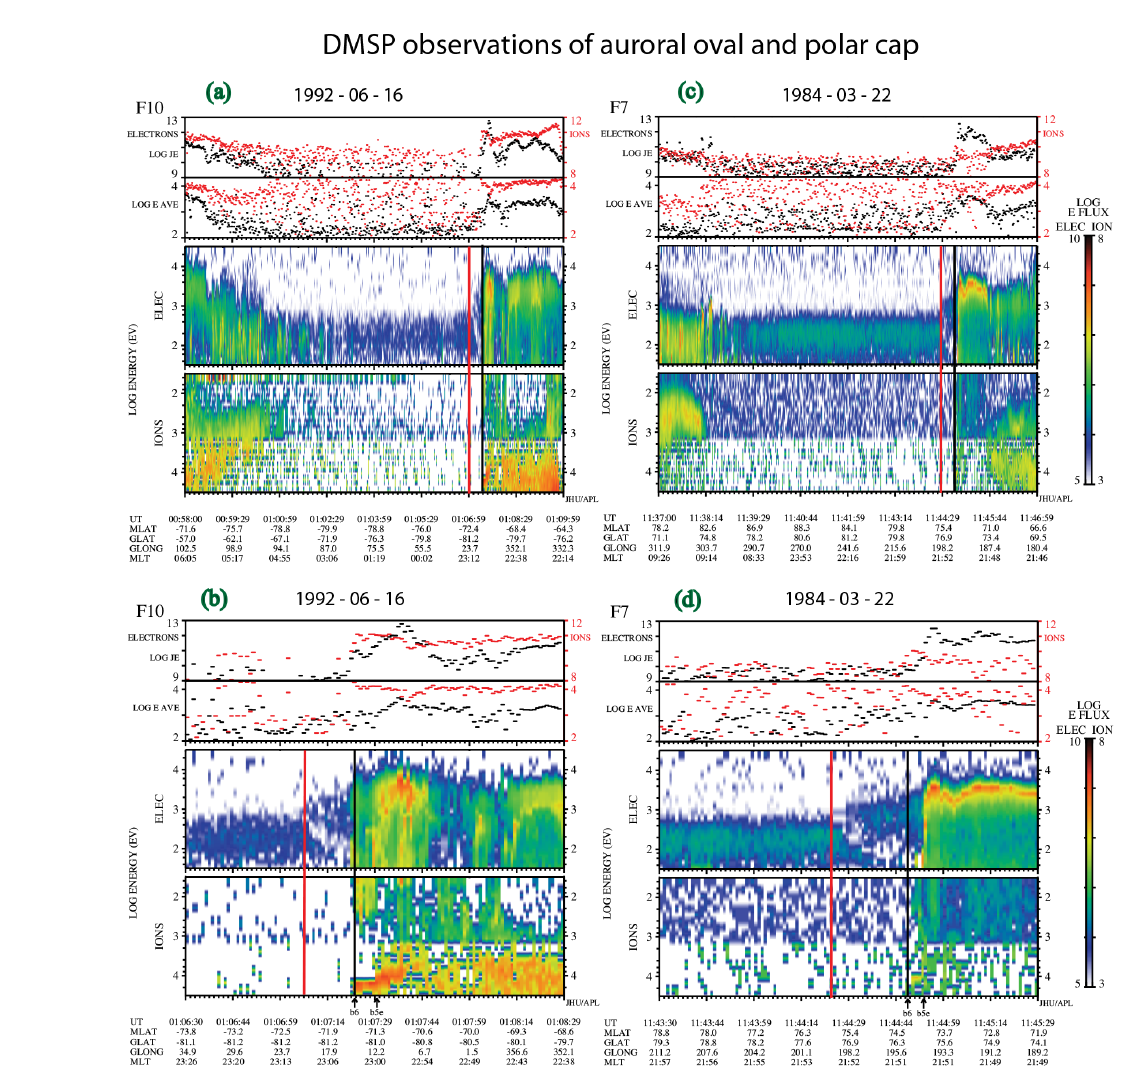
Figure 1. (a) and (c) DMSP observations of the auroral oval and polar cap. (b) and (d) zoom in on the nightside region where the polar rain meets the poleward edge of the auroral oval in (a) and (b) , respectively. (b) and (d) show the polar rain energy-latitude dispersion, b6, and b5e. The vertical red lines indicate the location of the highest energy polar rain electrons in the dispersion region while the vertical black lines indicate